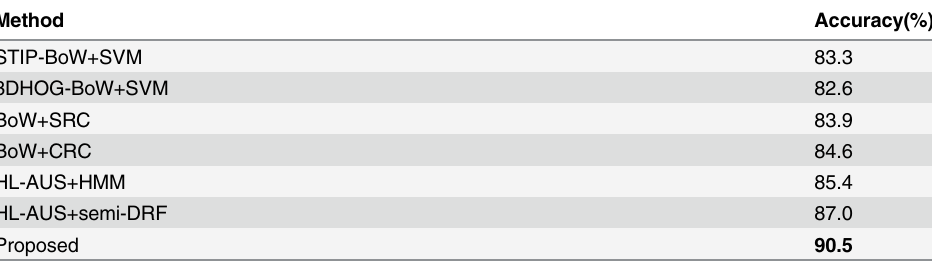
Table 4. Comparison with state of the arts on